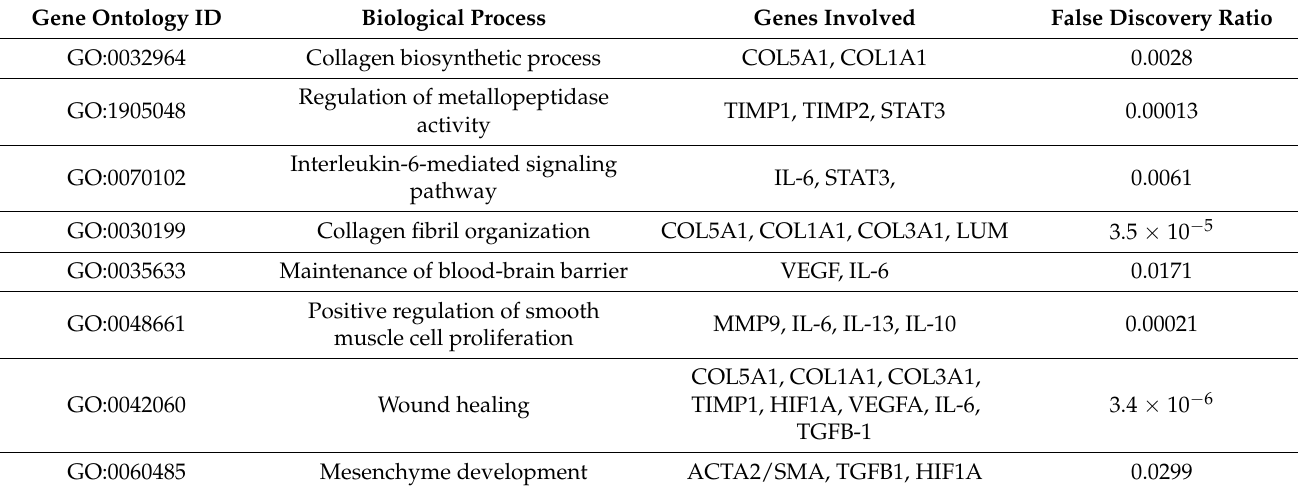
Figure 6. The network generated from the gene interactions involved between COL5A1 and TIMP1 ( A ). The network stats of the network in ( A ) showing the significance value of <1.0 × 10 − 16 ( B ). The RNA co-expression analysis from STRING software shows for the above network shows the COL3A1 and COL1A1 are highly co-expressing in the homeostatic conditions ( C ). Table 1. The above table shows the genes playing roles in specific biological processes from the network generated between COL5A1 and TIMP1 gene interactions, which has a significant role in corneal wound